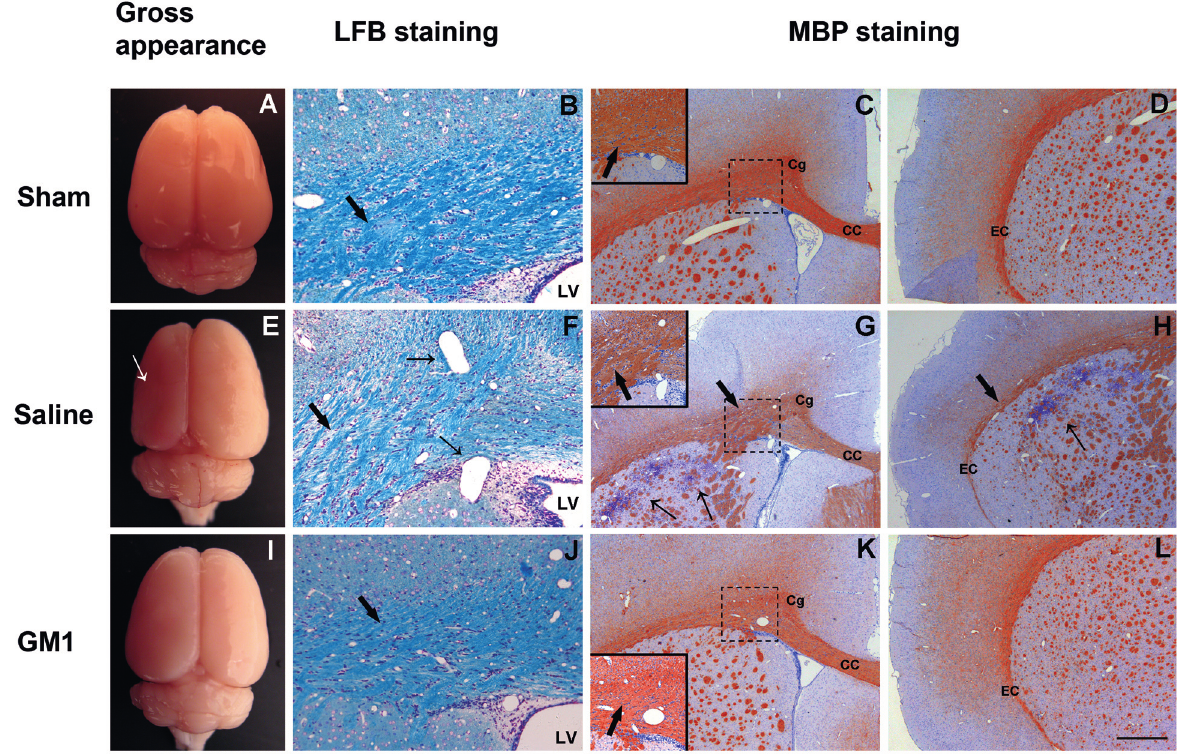
Figure 1. Morphological changes in gross brain (A, E, I) and myelin sheath detected by luxol fast blue (LFB) (B, F, and J) and myelin basic protein (MBP) (C, D, G, H, K, and L) staining in the three groups of P30 rats. After hypoxic-ischemic brain damage was induced, one group received an intraperitoneal injection of saline (Saline group) and another group was injected with monosialotetrahexosyl ganglioside (GM1; GM1 group). Sham-operated rats served as control (Sham group). The gross morphology of the Saline group brains (E) showed significant left cerebral hemisphere atrophy (the white arrow indicates the atrophied brain). Brains from the GM1 group (I) were similar to those from the Sham group (A). LFB staining in the corpus callosum (CC) and cingulum (Cg) showed compact myelin sheaths in the Sham group (thick black arrow; B) and clear structural abnormalities of rarefaction and fragmentation (thick black arrow) with distension of the blood vessels (thin black arrows) in the Saline group (F); whereas GM1 group (J) brains were similar to those of the Sham group rats, with improved myelin sheath density (thick black arrow). Immunohistochemical staining of MBP showed struc- tural abnormalities of rarefaction and fragmentation in the left CC and external capsule (EC; thick black arrows) in the Saline group (G, H), with infiltration of inflammatory cells in the left cerebral hemisphere (thin black arrows; G, H). A high magnification view shows abnormalities of myelin in the CC and Cg. The staining pattern of the left CC and EC of the GM1 groups (K, L) was similar to that of the Sham group (C, D), without structural abnormalities. Scale bars: 3 mm for A, E, and I; 125 μm for B, F, and J, and 500 μm for C, D, G, H, K, and L. For Panels C, G, and K, the area framed with dashed lines was zoomed in 1.8-fold and shown in insets with thick black arrows indicating the changes in myelin of NF155 in brain tissue and the NF155 level in the Saline group was significantly lower than that in the Sham group (Figure 3A) (P < 0.05). The NF155 level in the GM1 group was higher than that in the Saline group but lower than that in the Sham group, although the differences were not statisti- cally significant. Among the three groups, the Saline group showed the lowest level of NF155 in lipid rafts (Figure 3B). The lipid raft NF155 level in the GM1 group was significantly higher than that of the Saline group (fraction 3: 52.10 ± 4.54 vs 24.53 ± 5.55; fraction 4: 80.19 ± 3.84 vs 53.45 ± 7.97; fraction 5: 54.88 ± 3.27 vs 16.15 ± 2.20; all P < 0.05). The fold values for fractions 3, 4, and 5 were 0.56, 0.52, and 0.24, respectively, in the Saline group and 1.19, 0.77, and